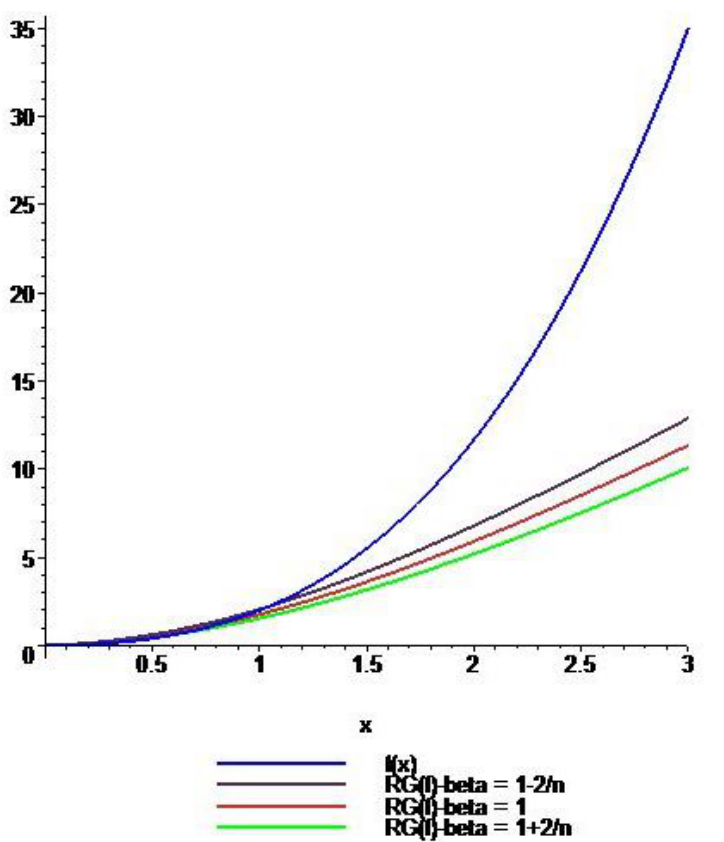
,1 and 1 + 2 , n = 25. n n